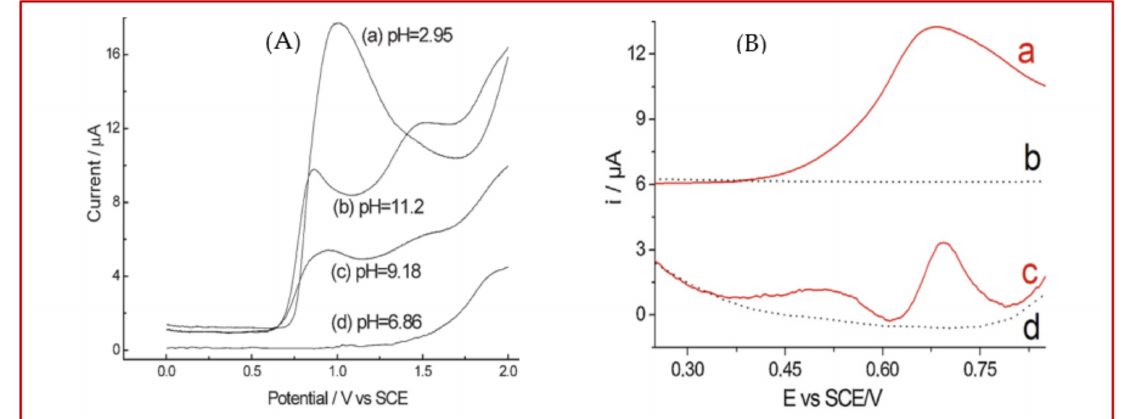
Figure 14. ( A ) Differential pulse voltammograms (DPVs) of Tyr and Trp using a BDD electrode in PBS with different pHs. Reprinted with permission from ref. [356]. Copyright 2006 Wiley. ( B ) DPVs of a mixture containing 2.4 mM Cys and 0.4 mM Tyr in PBS (0.1 M, pH = 7.4) at GCE (a) and OMC–GCE (c) where dotted lines present DPVs of GCE (b) and OMC–GCE (d) in a blank solution (PBS 0.1 M, pH = 7.4). Reprinted with permission from ref. [95]. Copyright 2013